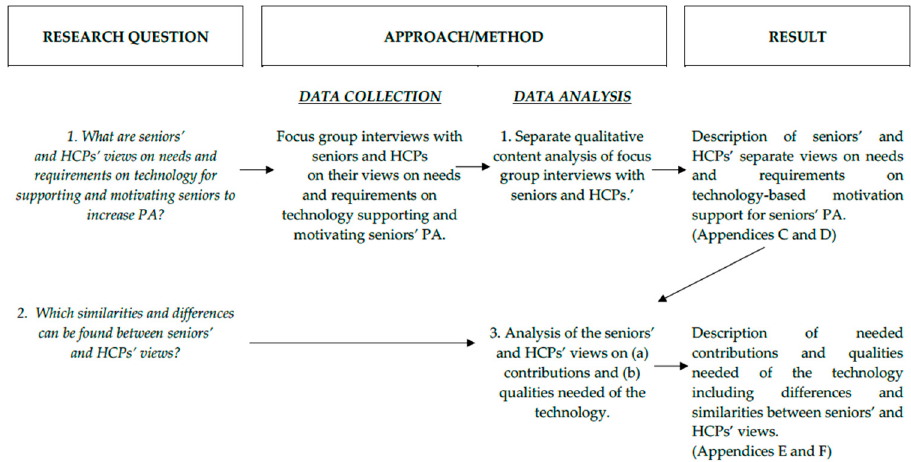
Figure 1. Overview of the study design.